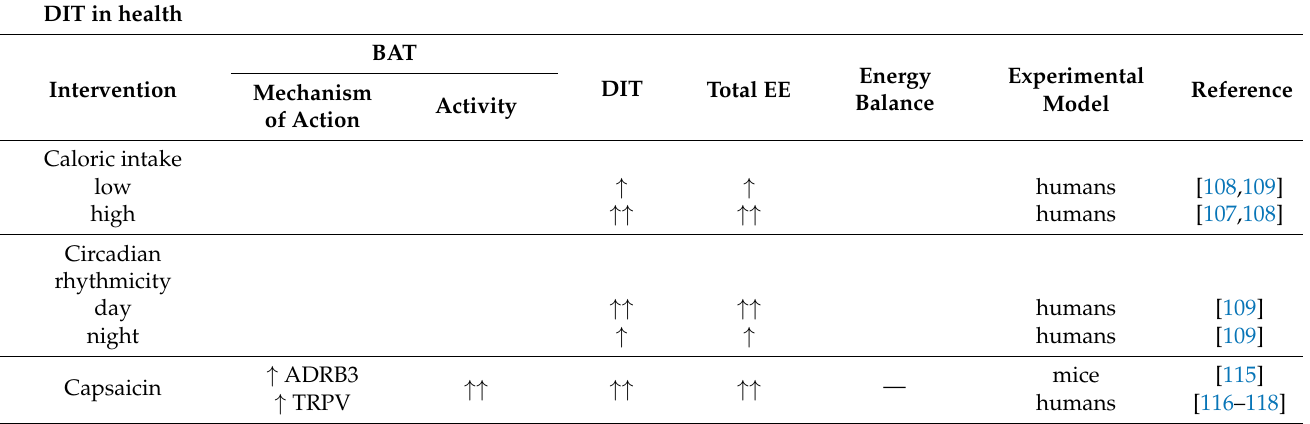
Table 1. The summary of the animal and human studies about BAT activity and DIT in health and